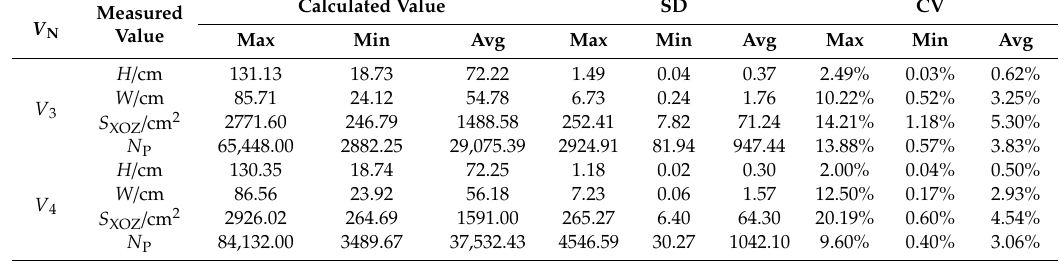
( h ) Figure 9. Calculation of the canopy volume of a greenhouse tomato plant: ( a ) Box filter: 2 mm; ( b ) Box filter: 3.3 mm; ( c ) Box filter: 5 mm; ( d ) Box filter: 8 mm; ( e ) Voxel: 2 × 2 × 2 mm 3 ; ( f ) Voxel: 3.3 × 3.3